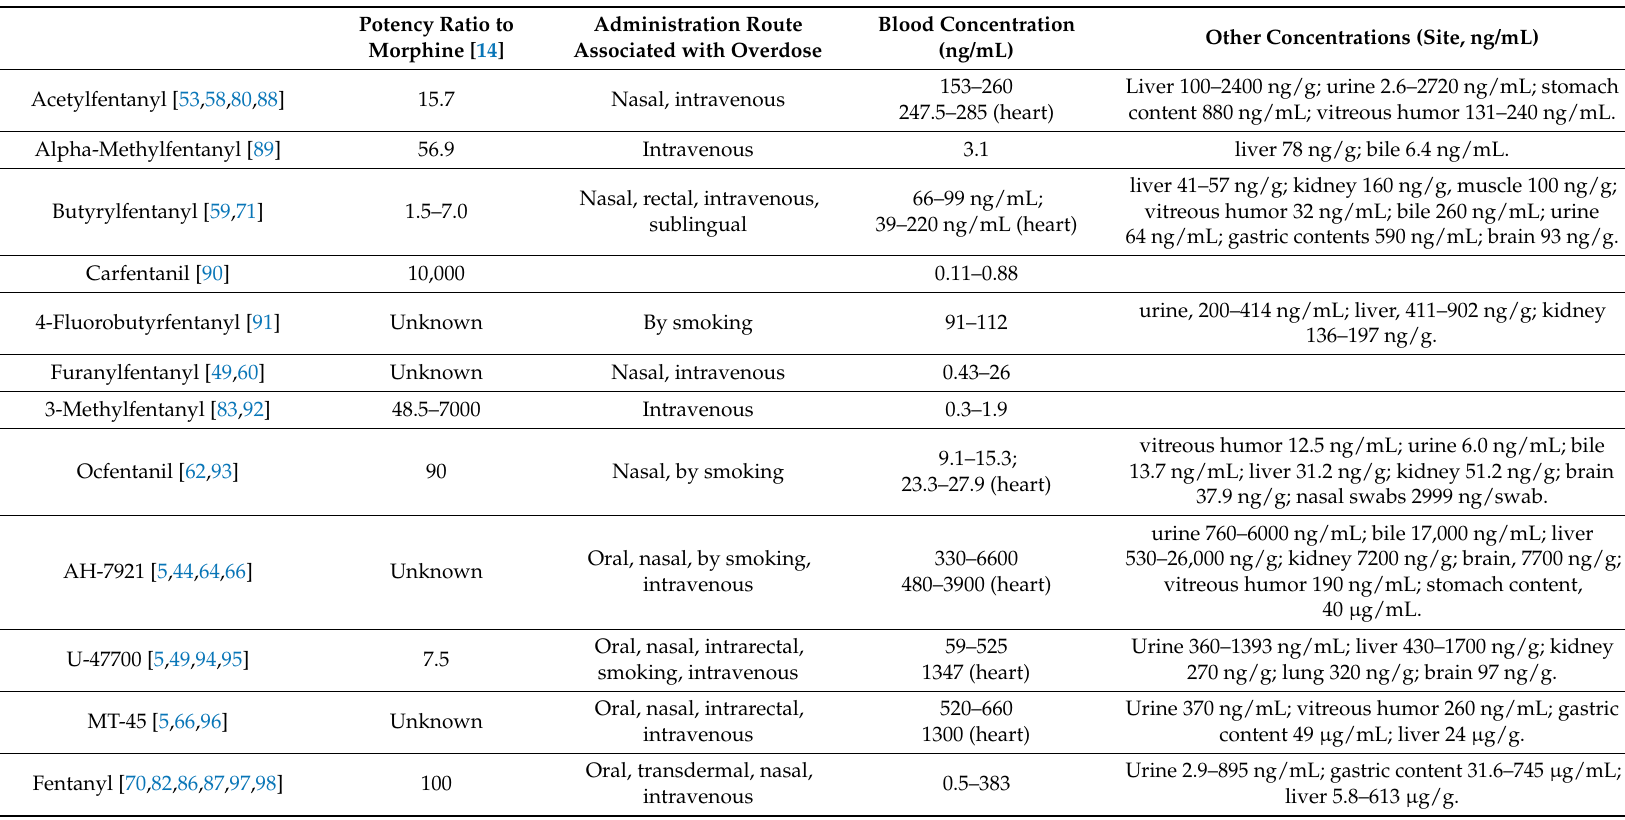
Table 1. Lethal concentrations data reported in the